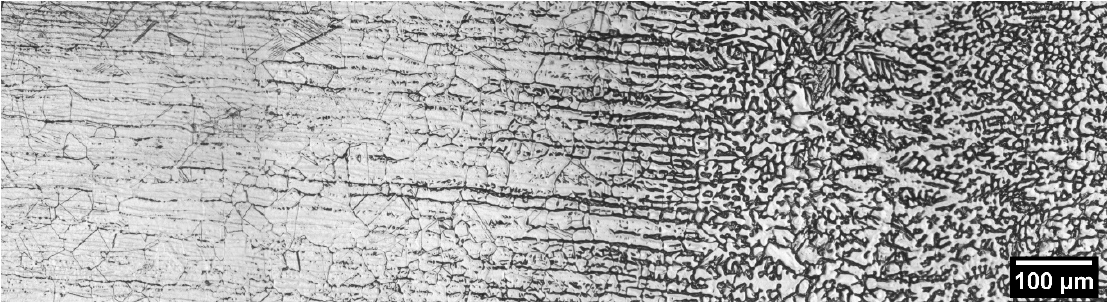
Figure 3. Transversal micrography of the non-rolled sample (1.5 mm thick) at the weld bead (right)/heat affected zone (HAZ) (left) interface.